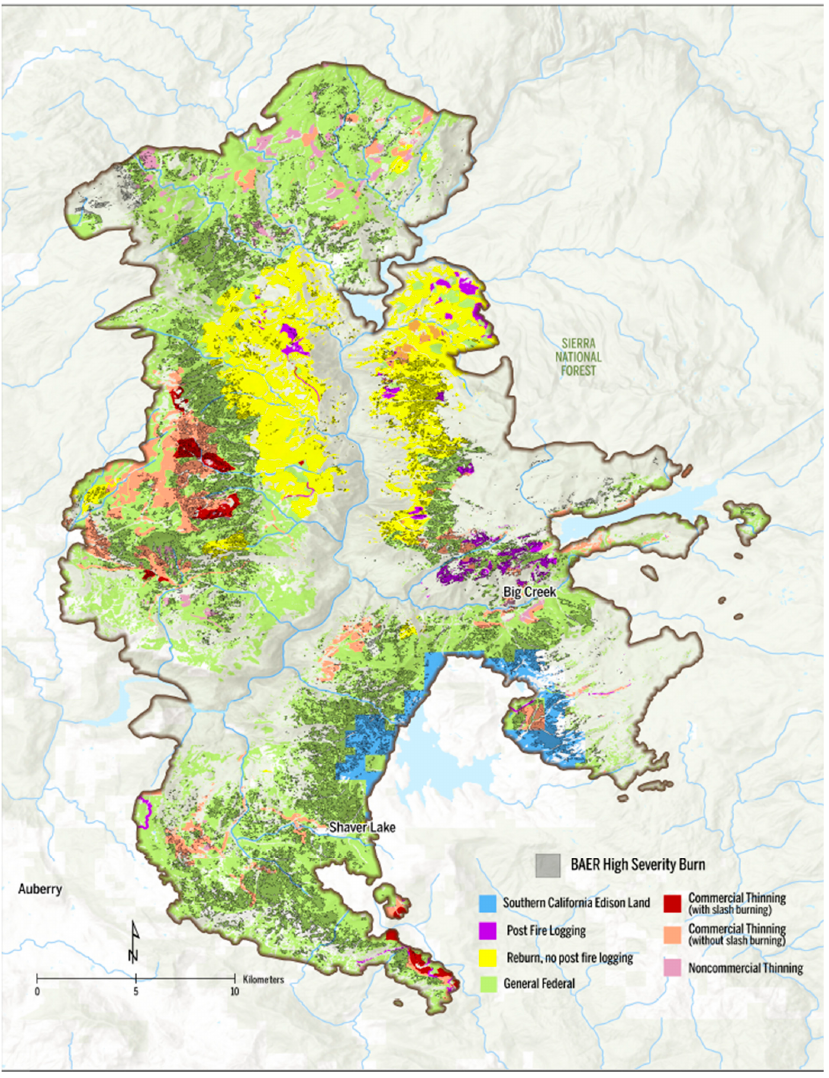
Figure 1. The Creek Fire study area, showing management categories and high ‐ severity fire during the first four days when the most extreme fire behavior occurred.